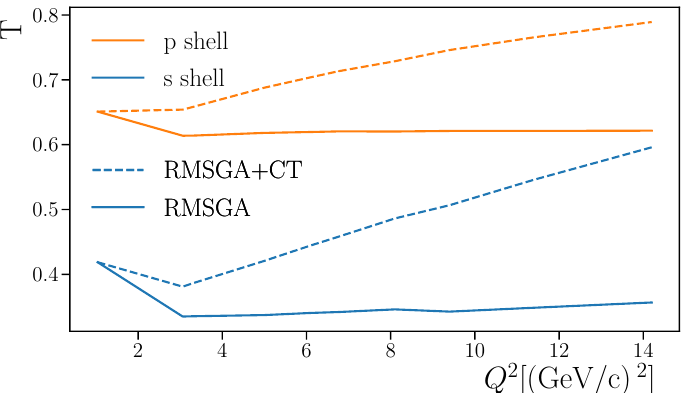
Figure 2. Nuclear ( e , e (cid:48) p ) transparencies for the s -shell (blue) and p -shell (orange) protons in 12 C versus Q 2 in quasielastic kinematics. Dashed curves include the CT